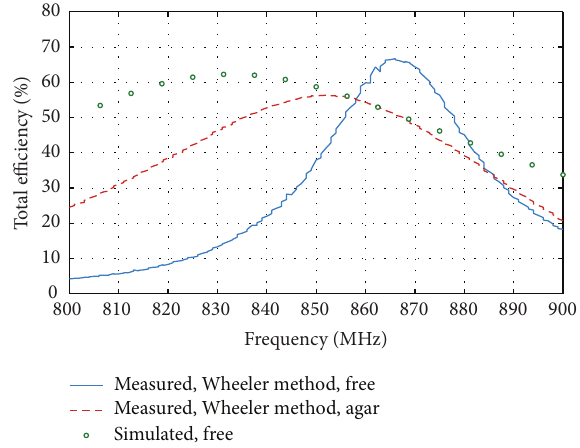
Figure 6: Simulation and measurement of the total efficiency of the vertically folded coupled patches tag